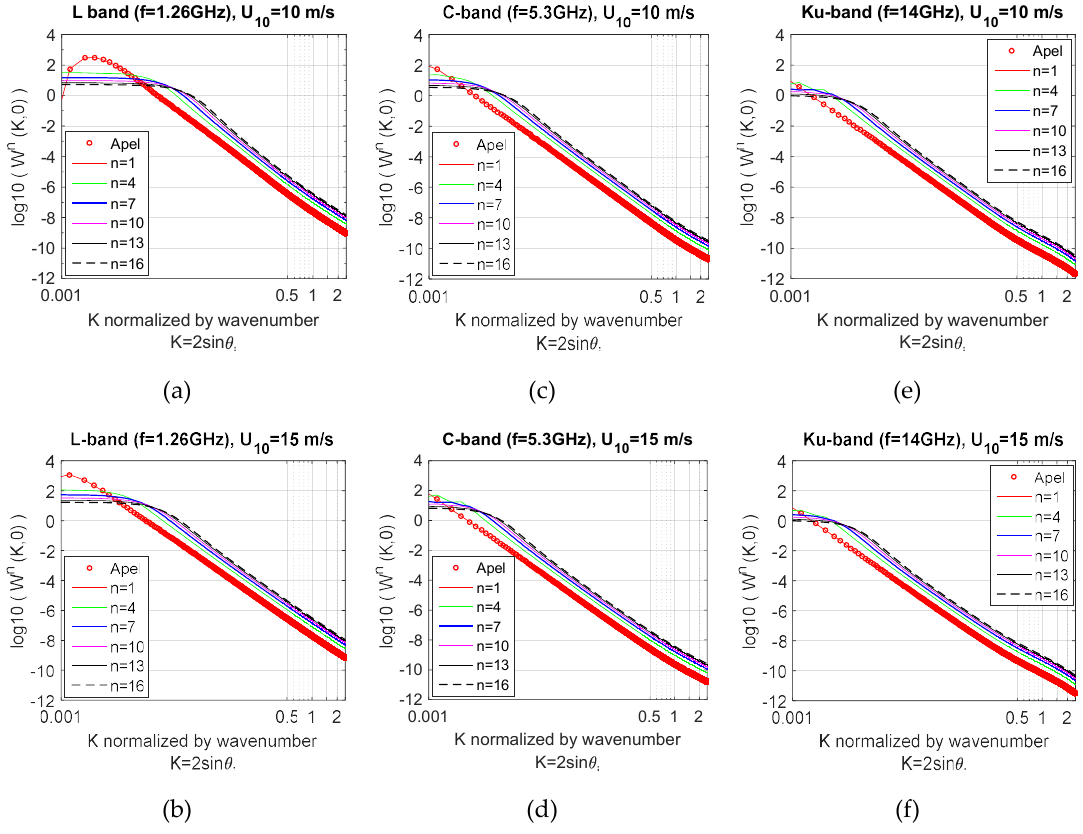
Figure 3. The variation of the relative importance of W (n) in the upwind direction with effective wavenumber K normalized by exploring wavenumber (L-, C-, and Ku-bands) and n at the wind speeds of 10 m/s and15 m/s, respectively. ( a )–( b ) k e ∈ [0.1* k , ∞ ); ( c )–( d ) k e ∈ [0.05* k , ∞ ); ( e )–( f ) k e ∈ [0.0005* k , ∞